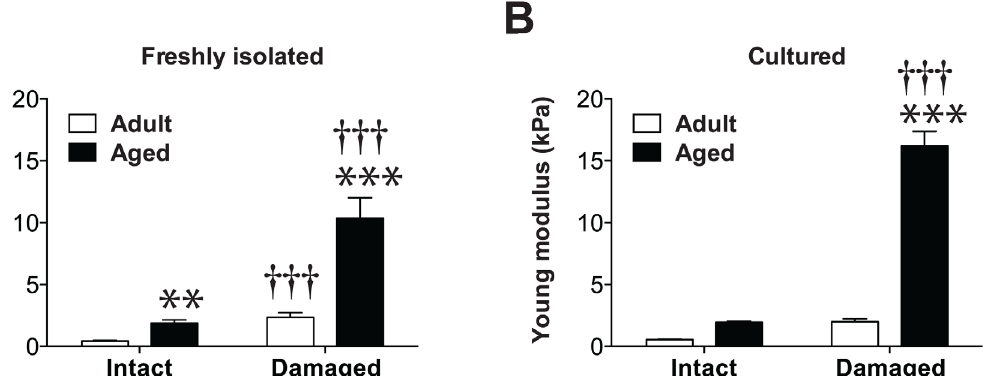
Fig 3. Damaged myofibers from aged mice display robust stiffness that impairs MPC activity. Graphs showing Young ’ s modulus values (kPa) and stiffness measurements of freshly isolated ( A ) and cultured intact and damaged myofibers ( B ) from adult ( n = 3) and aged ( n = 5) muscles. One measurement (three force-indentation curves collected for each measurement) per myofiber was performed on 6 – 50 myofibers. ** p < 0.01; *** p < 0.0001 versus adult counterpart. ††† p < 0.001 versus intact counterpart. All data are expressed as means ± SEM.